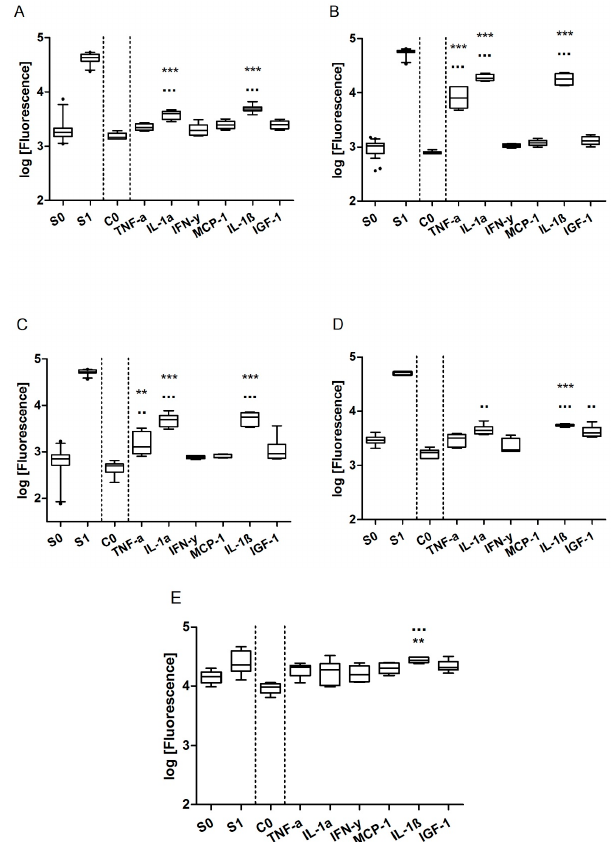
Figure 2. Secretion of IL-8 ( A ), Rantes (B), IL-6 ( C ), MCP-1 ( D ), and CXCL10 ( E ) after stimulation with